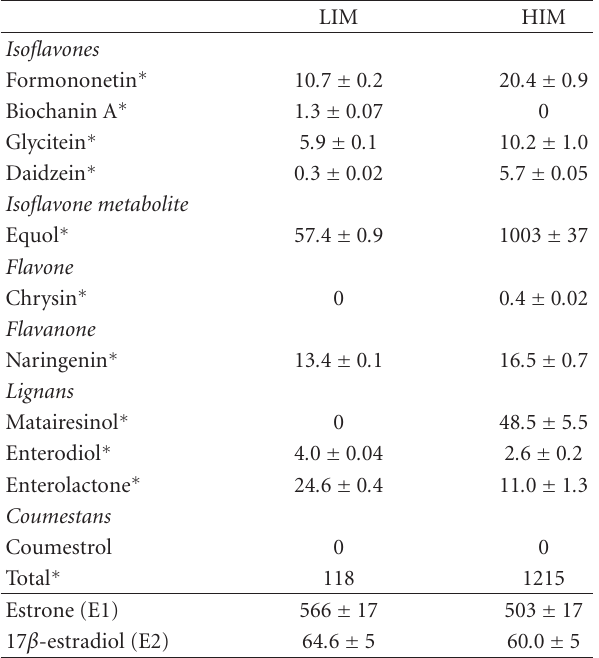
Table 2: Total concentrations (free and conjugated) of the mea- sured phytoestrogens (ng/ml) and endogenous estrogens E1 and E2 (pg/mL) in high (HIM) and low (LIM) isoflavone